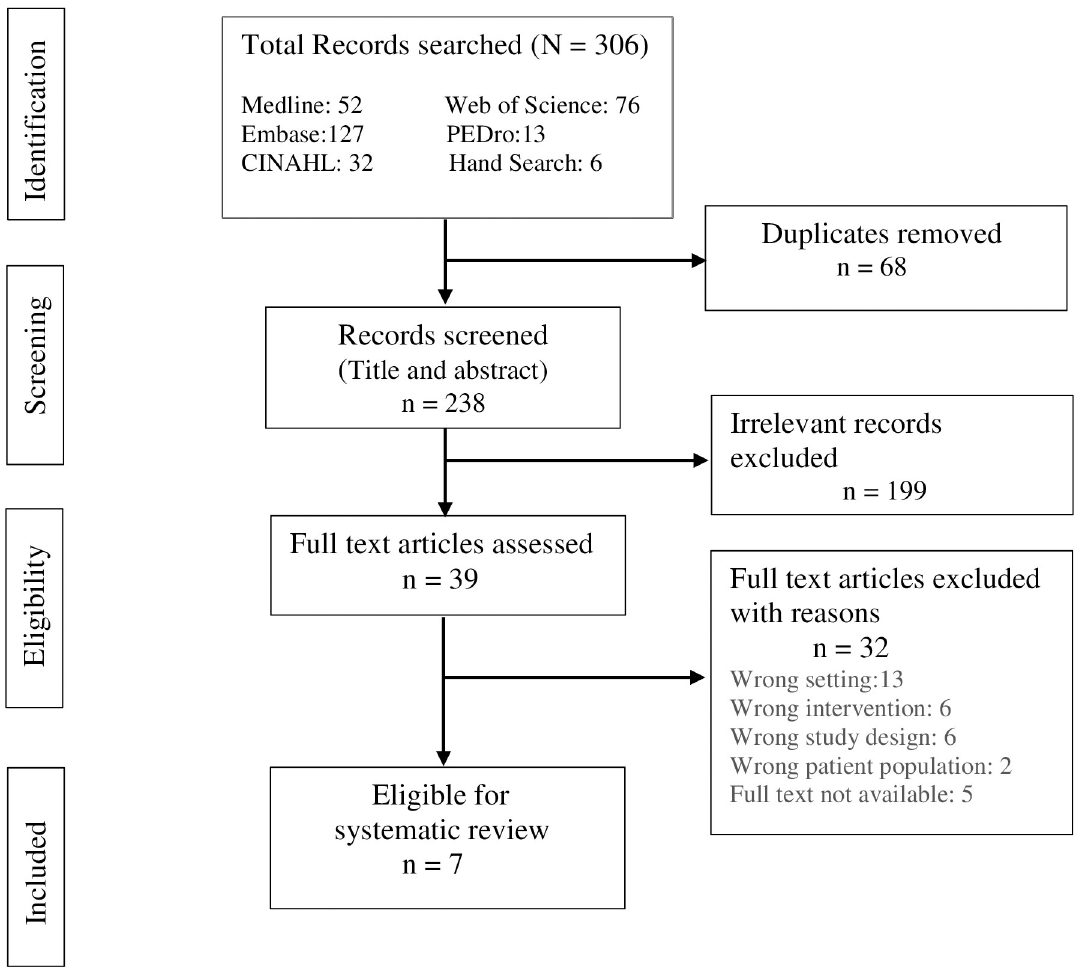
Fig 1. PRISMA flow